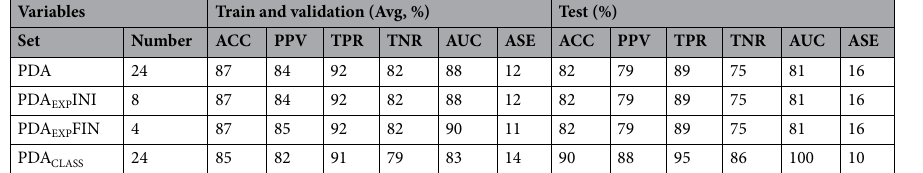
Table 8. Performance of gradually reduced set of variables for the PDA data set.